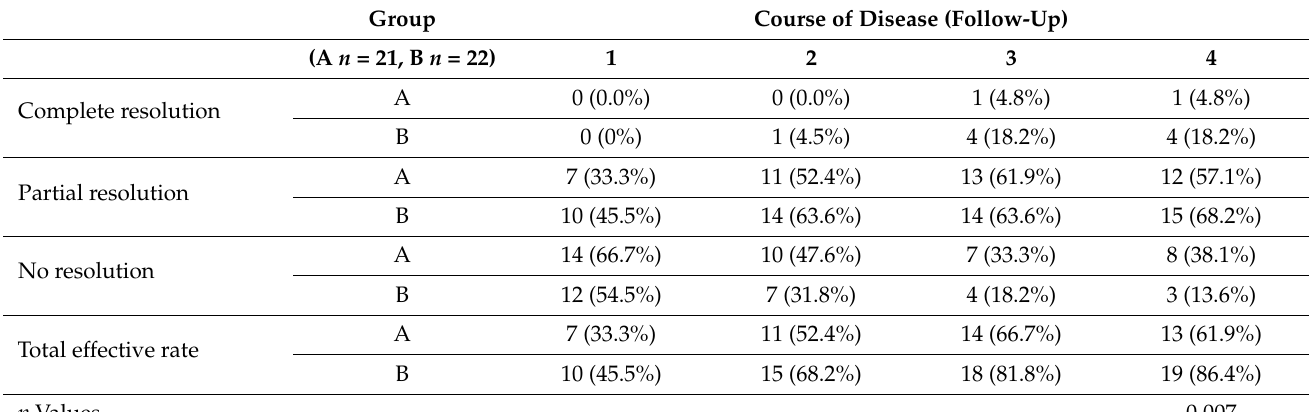
Table 3. Comparison of the treatment effective rate between the two groups (mITT).